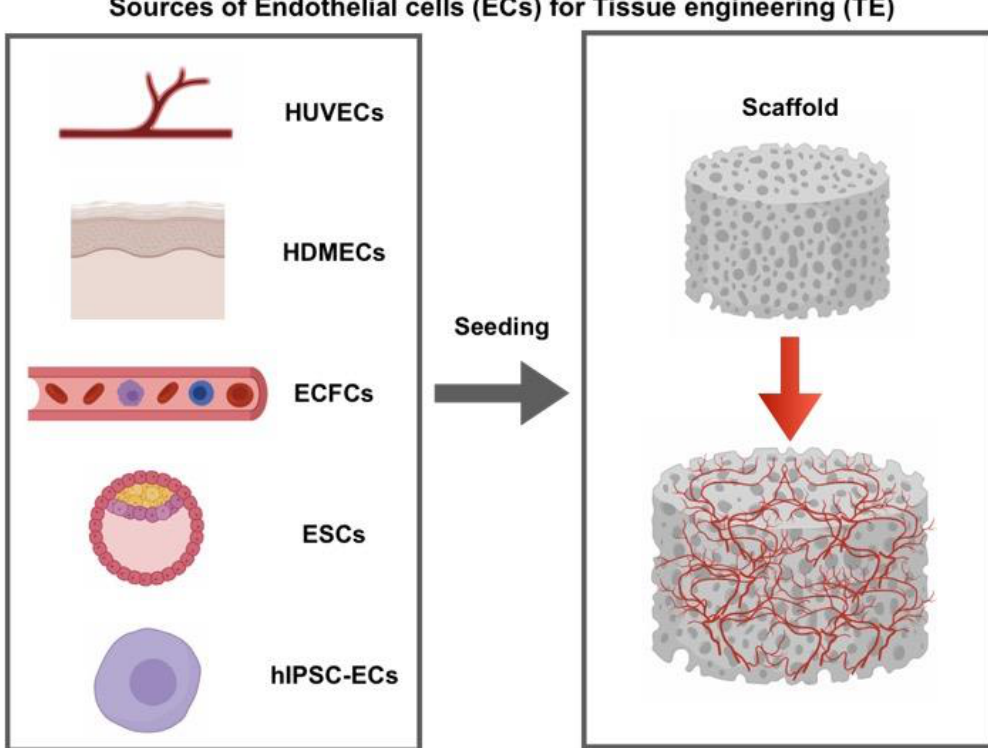
Figure 1. Sources of endothelial cells (ECs) used in scaffold-based approaches for tissue engineering (TE). HUVECs: Human Umbilical Vein Endothelial Cells, HDMECs: Human Dermal Microvascular Endothelial Cells, ECFCs: Endothelial Colony Forming Cells, ESCs: Embryonic Stem Cells, hIPSC-ECs: Endothelial Cells derived from Human Induced Pluripotent Stem Cells.